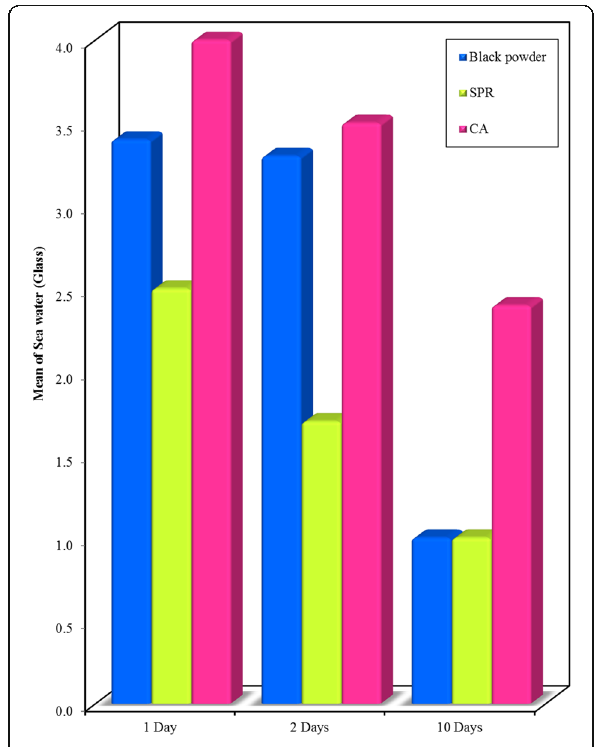
Fig. 6 Bar graph - Comparison between the Black powder, SPR and CA development techniques at different time intervals (1, 2, and 10 days) on glass surface recovered from sea water . Showing highest mean visibility score with